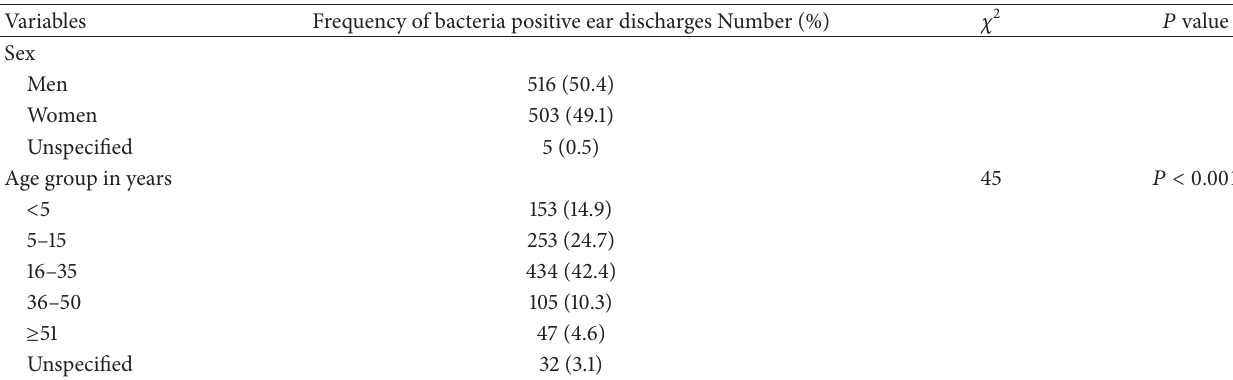
Table 1: Age and sex distribution of bacteria positive middle ear discharges diagnosed from 2001 to 2011 in Dessie Regional Laboratory ( 𝑛 = 1024 ).